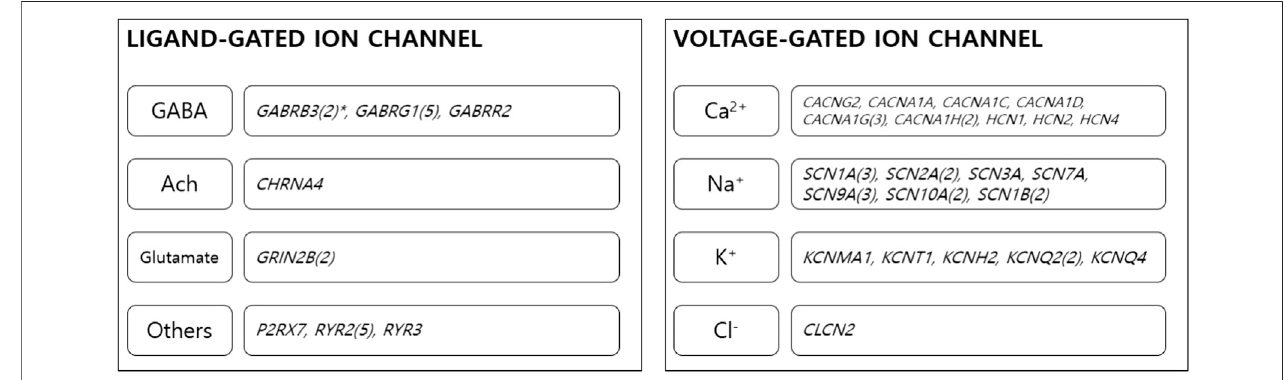
FIGURE 2 | Ion channel genes. Thirty genes were classi fi ed as ion channel-related genes. The genes were involved in the function of several ion channels. *Numbers in brackets stand for number of overlapping genes among children with ASD. GABA, gamma aminobutyric acid; Ach, acetylcholine.